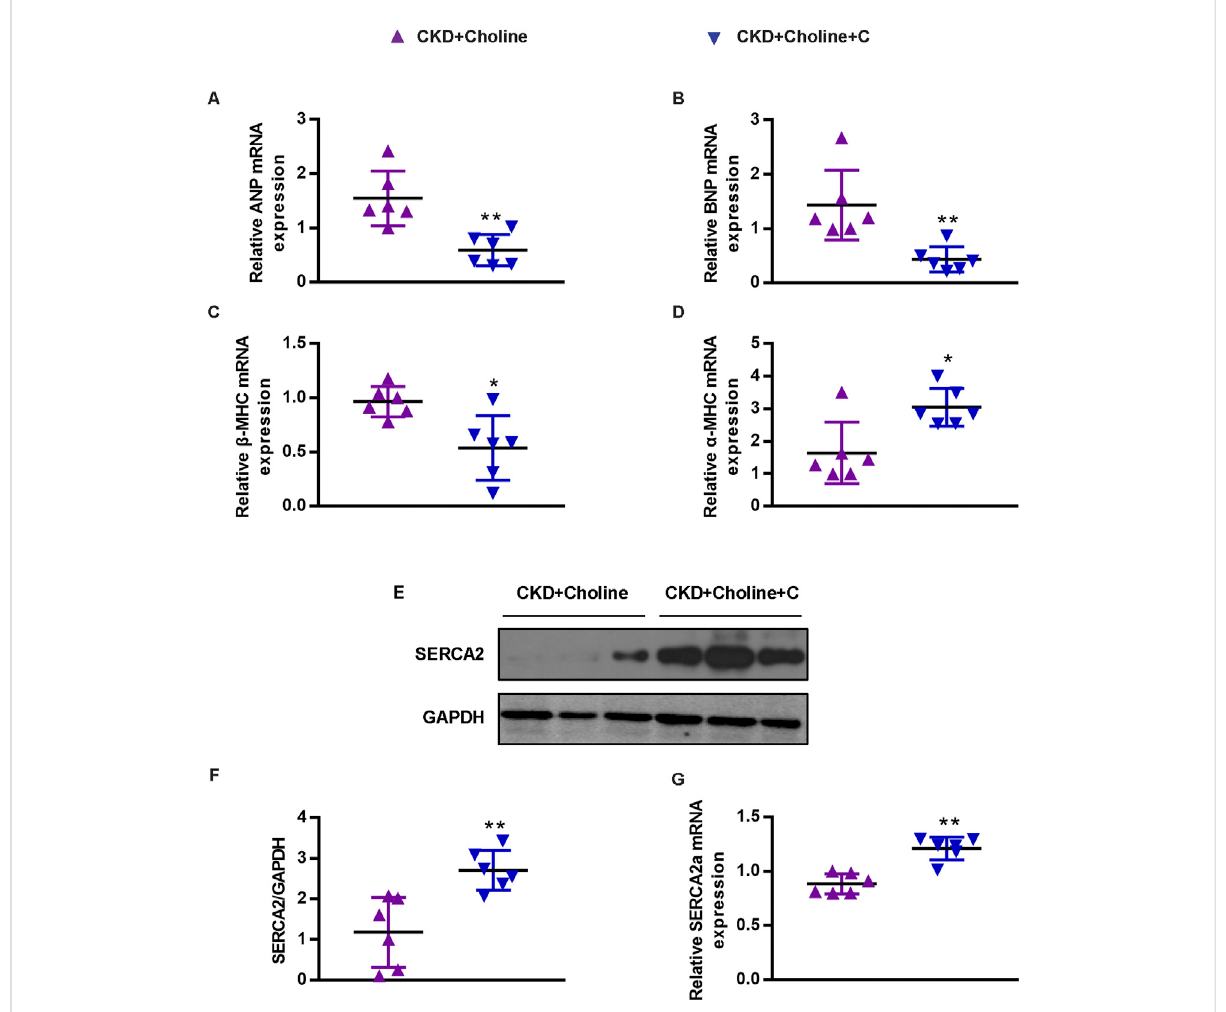
FIGURE 4 Medicinal charcoal tablets inhibit the changes of cardiac hypertrophy markers and SERCA2 expression in 5/6 Nx mice on a high-choline diet. (A-D) The mRNA levels of ANP, BNP, β -MHC, and α -MHC were measured by real-time PCR. (E) The protein levels of SERCA2 were measured by westernblotting. (F) GraphicrepresentationofrelativeabundanceofSERCA2normalizedtoGAPDH. (G) ThemRNAlevelsofSERCA2weremeasured by real-time PCR. The data are presented as the mean ± SD. * p < 0.05 and ** p < 0.01 vs. CKD + Choline group. n = 6 in each